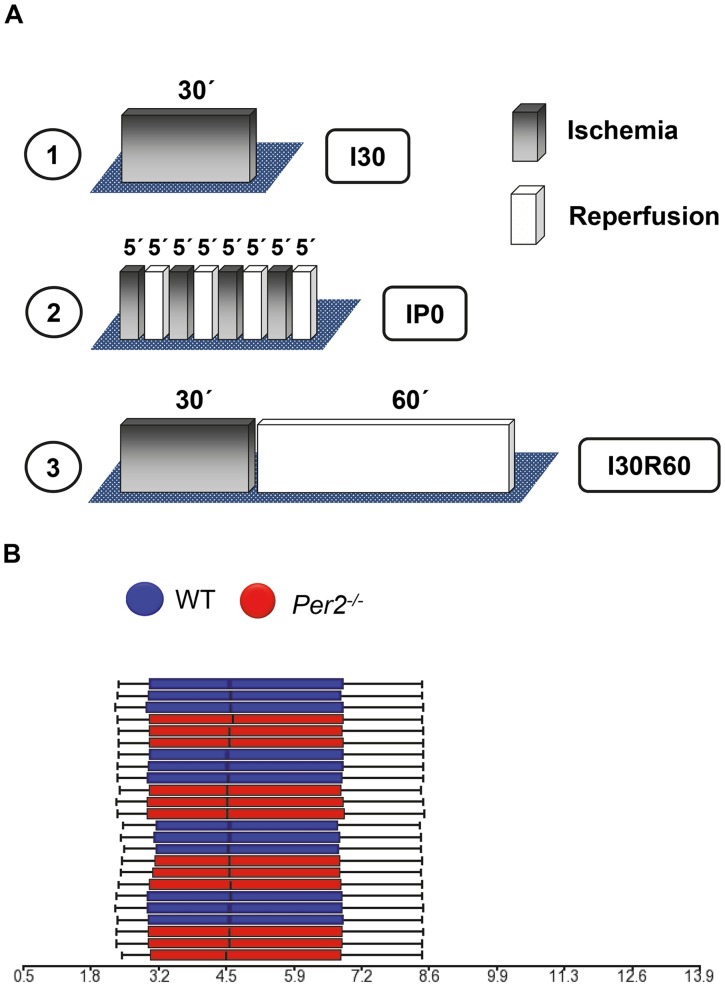
Microarray design comparing wildtype and Per2
−
/− mice.(A) Different ischemia and reperfusion protocols used on one 24 multi-plate array. 1.) 30 minutes of ischemia without reperfusion, I30. 2.) Ischemic preconditioning consisting of 4×5 minutes of ischemia followed by 5 minutes of reperfusion each, IP0. 3.) 30 minutes of ischemia and 60 minutes of reperfusion, I30R60. (B) Box plots for each of the samples with the intensity (arbitrary units) of the probes graphed on the X-axis to identify outliers in the data set.